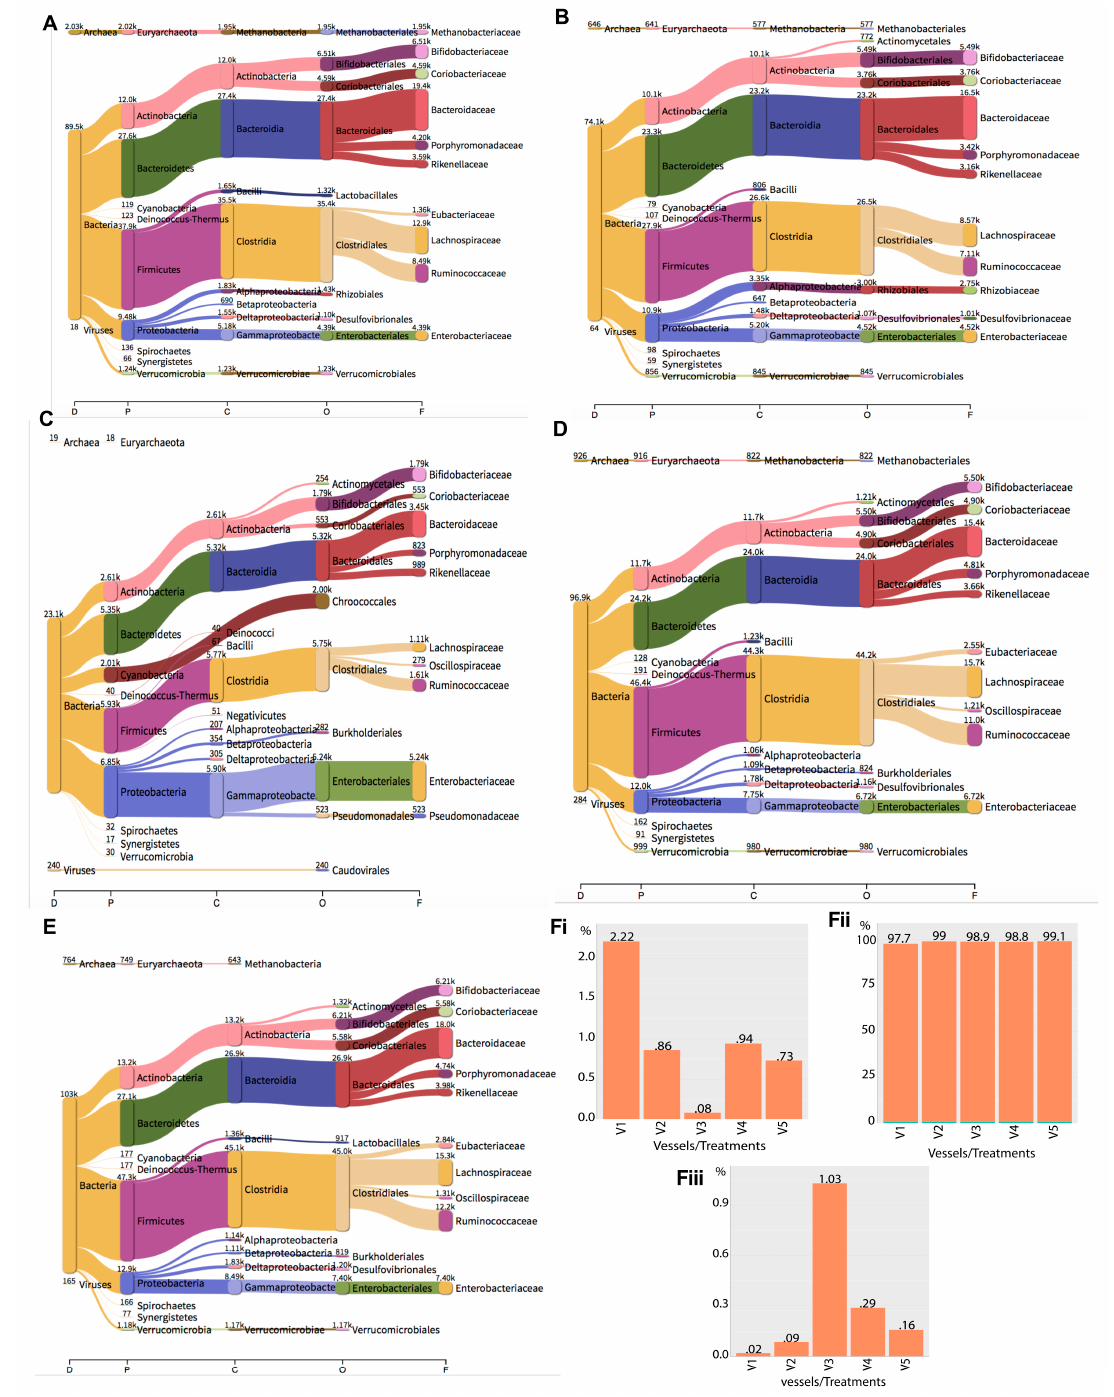
Figure 3. Analysis of the 10 most abundant taxa from Archea, Bacteria, and Viruses as ascertained by the metagenomics data. Total genomic DNA was extracted at 24 h time point from ( A ) vessel 1, untreated slurries; ( B ) vessel 2, C. difficile control; ( C ) vessel 3, phage-only-treated control; ( D ) vessel 4, prophylaxis regimen; ( E ) vessel 5, remedial regimen. The samples were prepared using NexteraXT sample preparation kit and sequenced on MiSeq platform using V2 (2 × 250 bp) chemistry. The resulting fastq files were trimmed with Sickle, and the metagenomes were assembled using megahit. An overview of the 10 most abundant taxa: Phyla (P), Classes (C), order (O), and family (F) are shown for each treatment vessel, as visualised using Pavian. The percent reads mapped to Archaea, Bacteria, and Viruses in the vessels at 24 h are shown in ( Fi ), ( Fii ), and ( Fiii ), respectively.